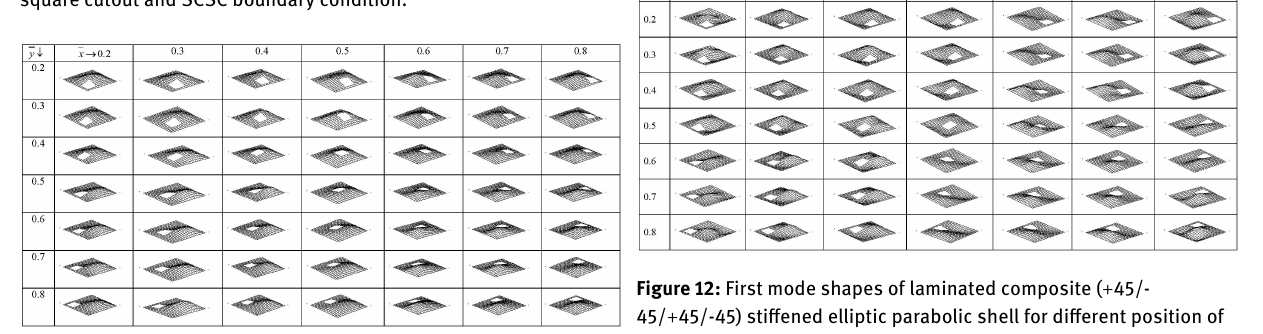
Figure 9: First mode shapes of laminated composite (0/90/0/90) stiffened elliptic parabolic shell for different position of the central square cutout and SSSC boundary condition.